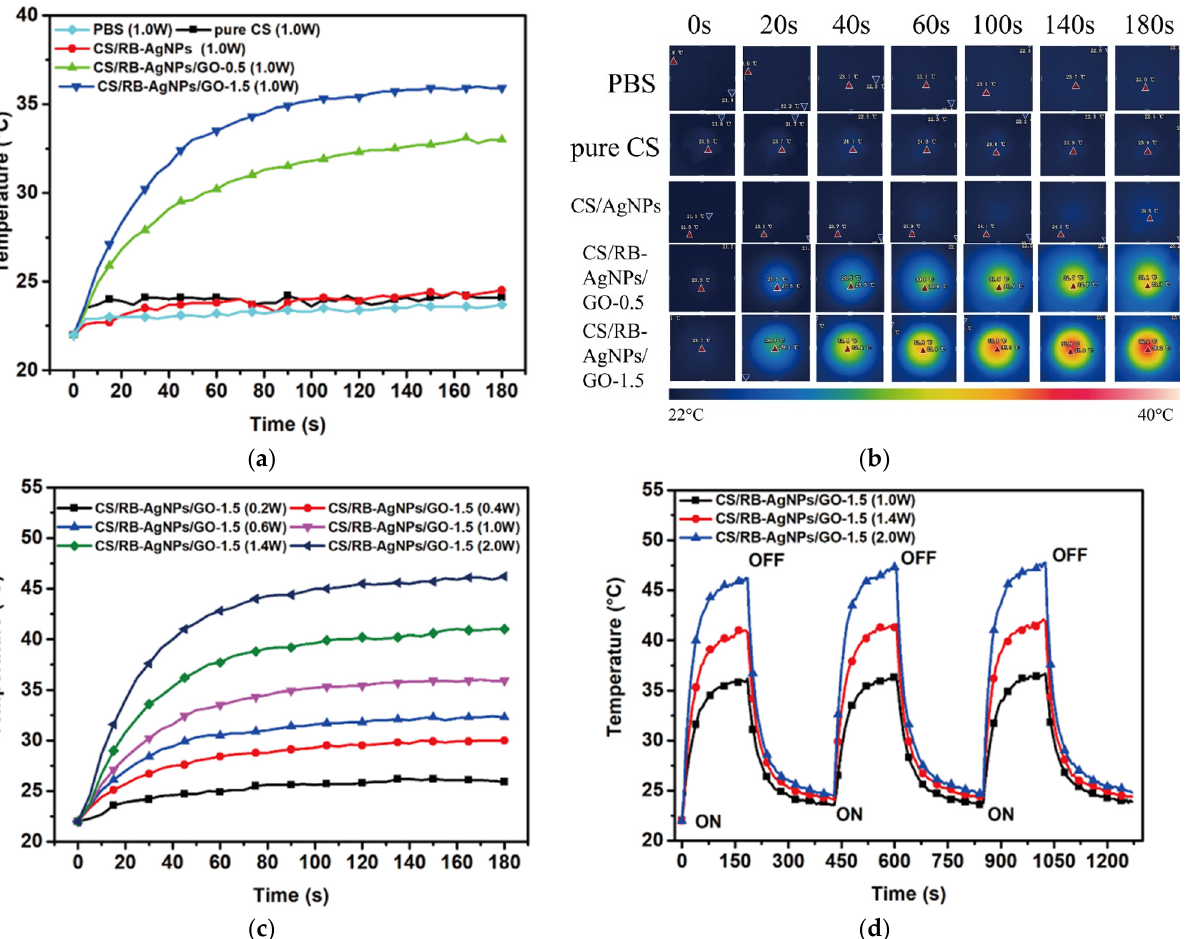
Figure 9. Photothermal conversion of all testing samples (a) Temperature profile and (b) IR thermal images of PBS solution control, pure CS, CS/RB-AgNPs, CS/RB-AgNPs/GO-0.5, and CS/RB-AgNPs/GO-1.5 under 808 nm continuous wavelength laser irradiation (1.0 W) from 0 to 3 min. (c) Temperature profile of CS/RB-AgNPs/GO-1.5 with different power from 0.2 to 2.0 W. (d) Photothermal conversion stability of CS/RB-AgNPs/GO-1.5 irradiated by 808 nm laser (power: 1.0, 1.4, and 2.0 W). The sample was irradiated by 3 min and then cooled down to 23 °C with three repeating cycles (For interpretation of the references to color in this figure legend, the reader is referred to the web version of this article.).